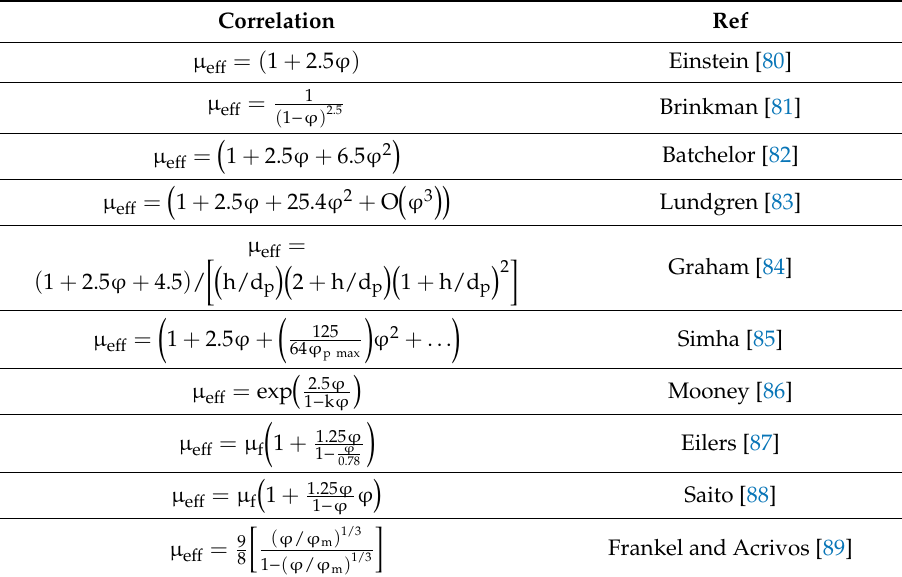
Table 5. Relationships obtained for nanofluid viscosity.